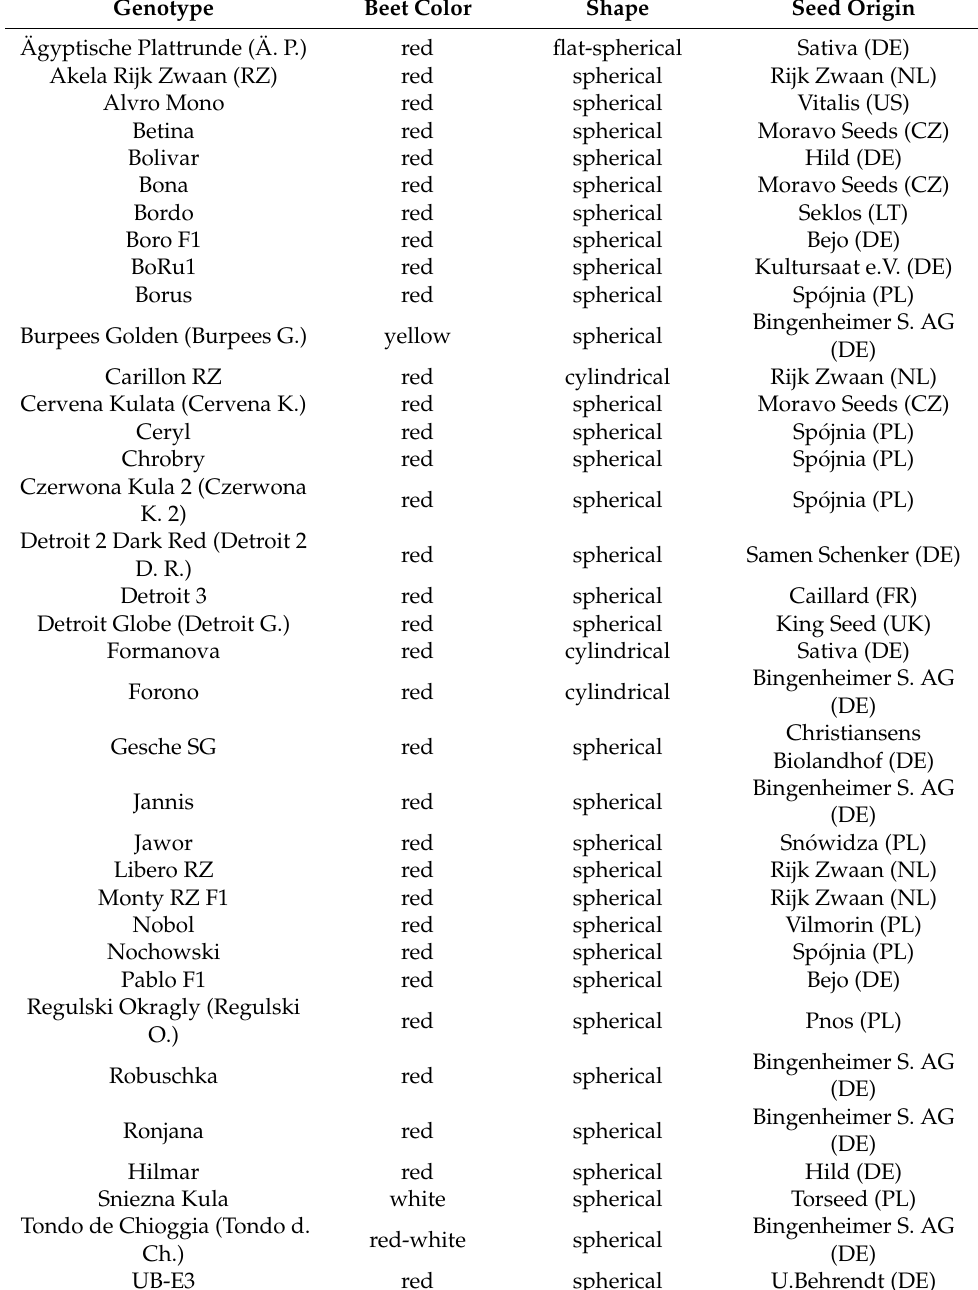
Regulski Okragly (Regulski O.) Robuschka spherical Tondo de Chioggia (Tondo d. Ch.)